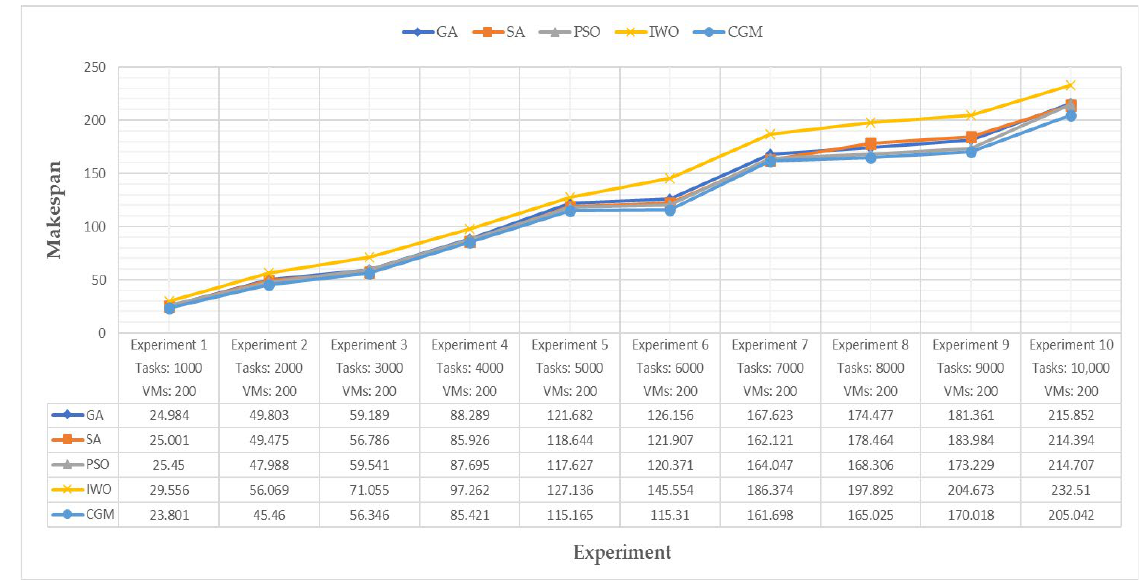
Figure 15. Scalability of the CGM mechanism for the BoT scheduling problem compared with other algorithms.